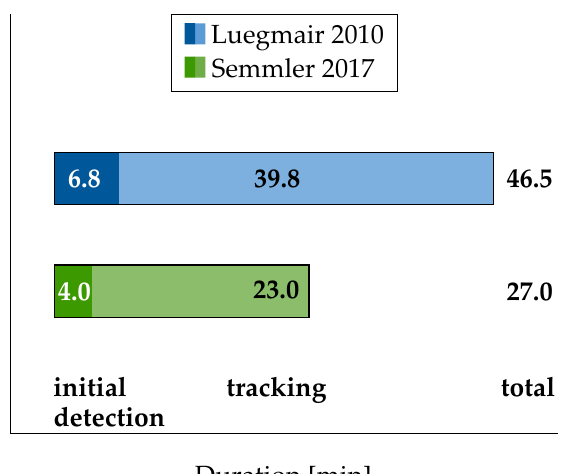
Figure 16. Evaluation of total duration of the laser point detection algorithm compared to its previous implementation by [20] subdivided in the initial grid detection and the tracking algorithm.